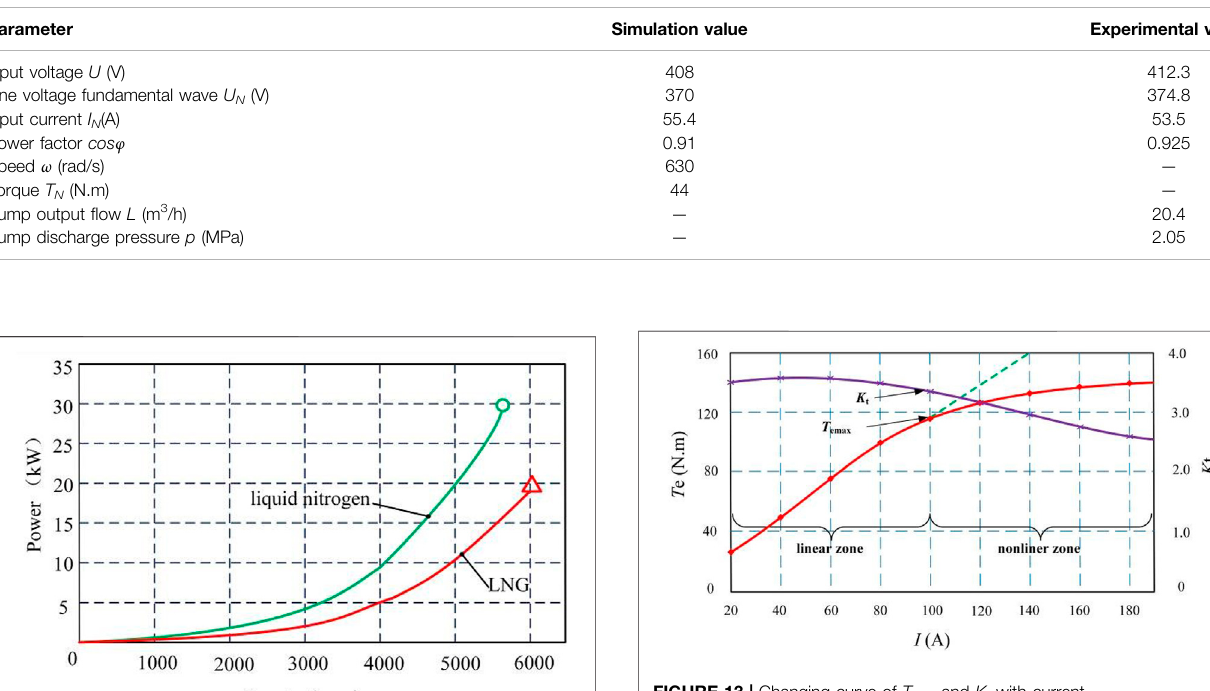
TABLE 4 | Simulation and experiment results of the prototype in liquid nitrogen ( − 196 ° C).